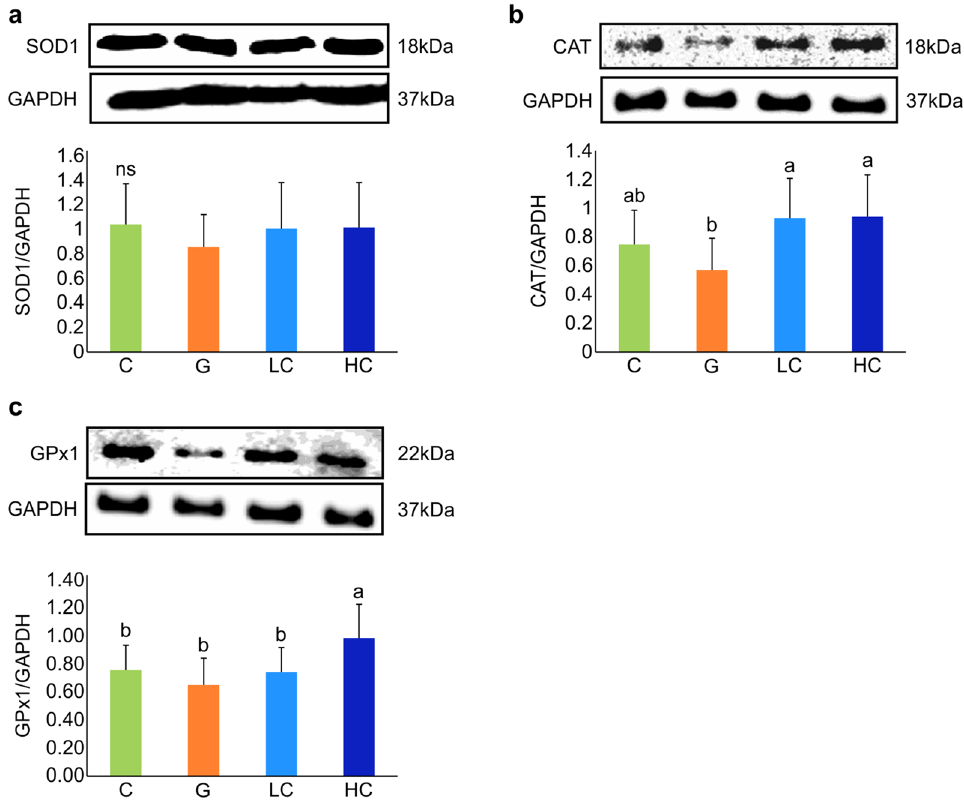
Figure 5. Effect of cacao on protein expression levels of antioxidant enzymes. ( a ) Expression levels of SOD1; ( b ) CAT; ( c ) GPx1. Values represent mean ± SD, n = 8. ns: not significant; Means for a variable with different letters (a, b) differ significantly ( p < 0.05). C, control; G, d-galactose-induced aging; LC, d-galactose injection with 10% cacao powder mixed diet; HC, d-galactose injection with 16% cacao powder mixed